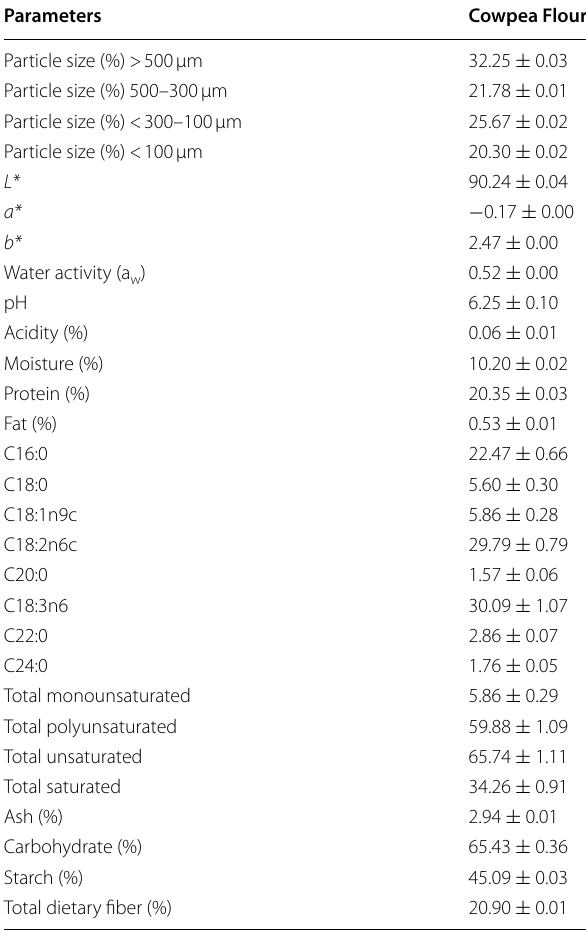
Values are means